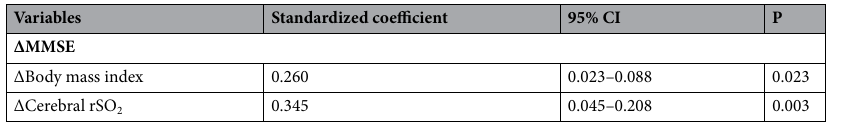
Table 3. Multivariable linear regression analysis: independently associated factors of changes in MMSE. CI confidential interval, MMSE Mini-Mental State Examination, rSO 2 regional oxygen